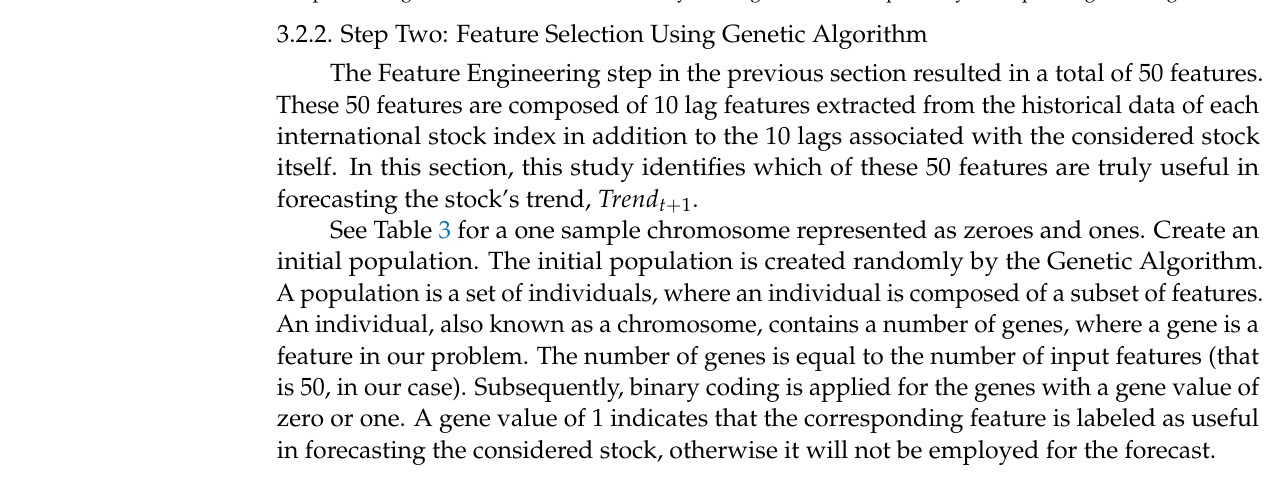
Table 3. One sample chromosome of population represented as a set of zeroes and